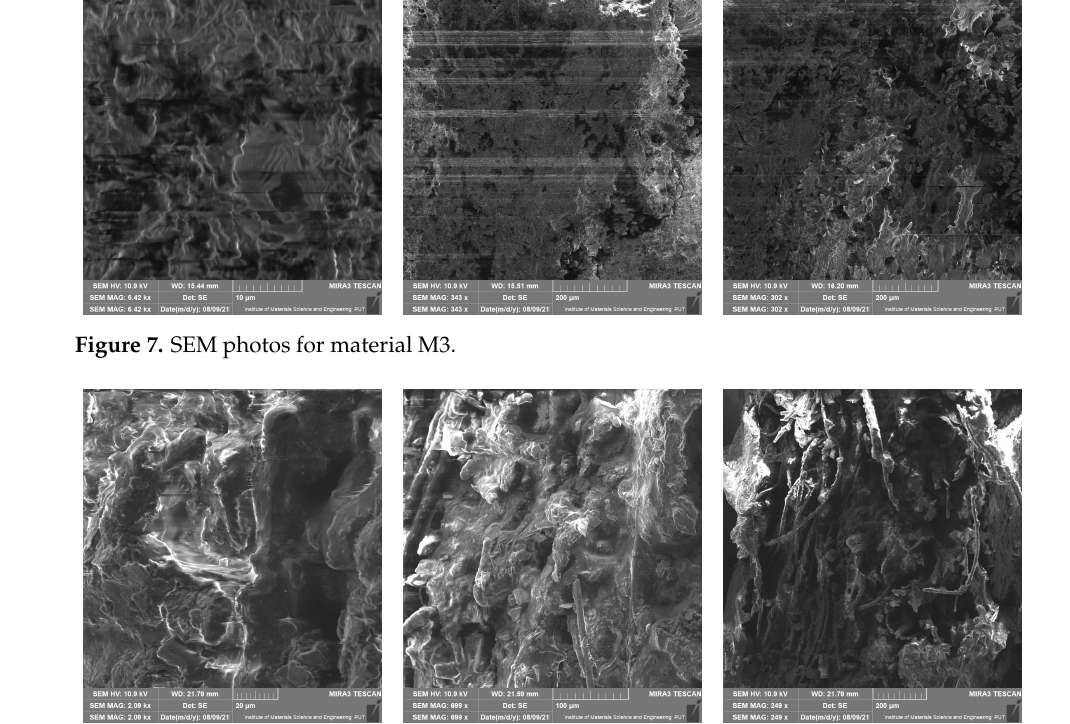
Figure 8. SEM photos for material M4.